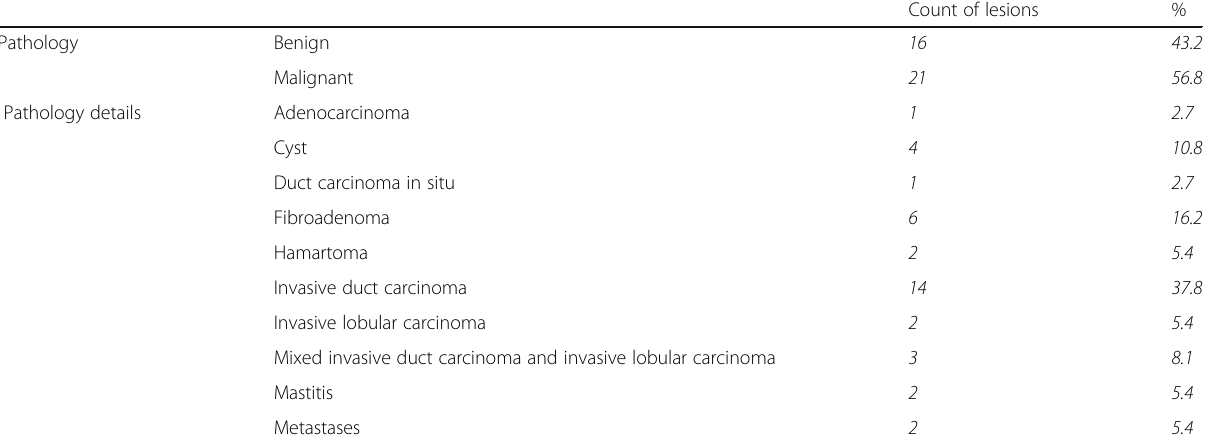
Count of lesions